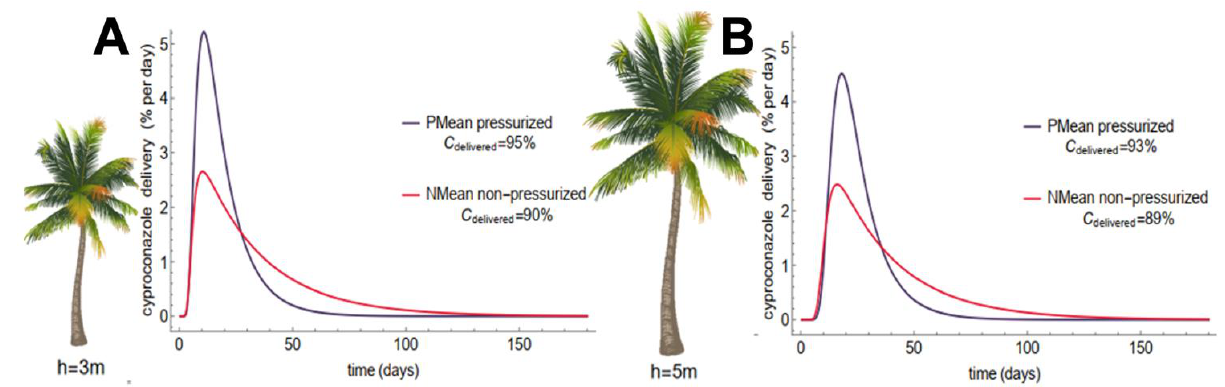
Figure 2. Dynamics of cyproconazole translocation from stem to leaves for coconut palms of different heights using pressurized ( A ) and nonpressurized methods ( B ). The release rate was calculated using equation (2) (Video S1). The percentage of cyproconazole applied to the leaves after 180 days for each simulation is indicated by the c delivered and was calculated using equation (3) (Video S2).